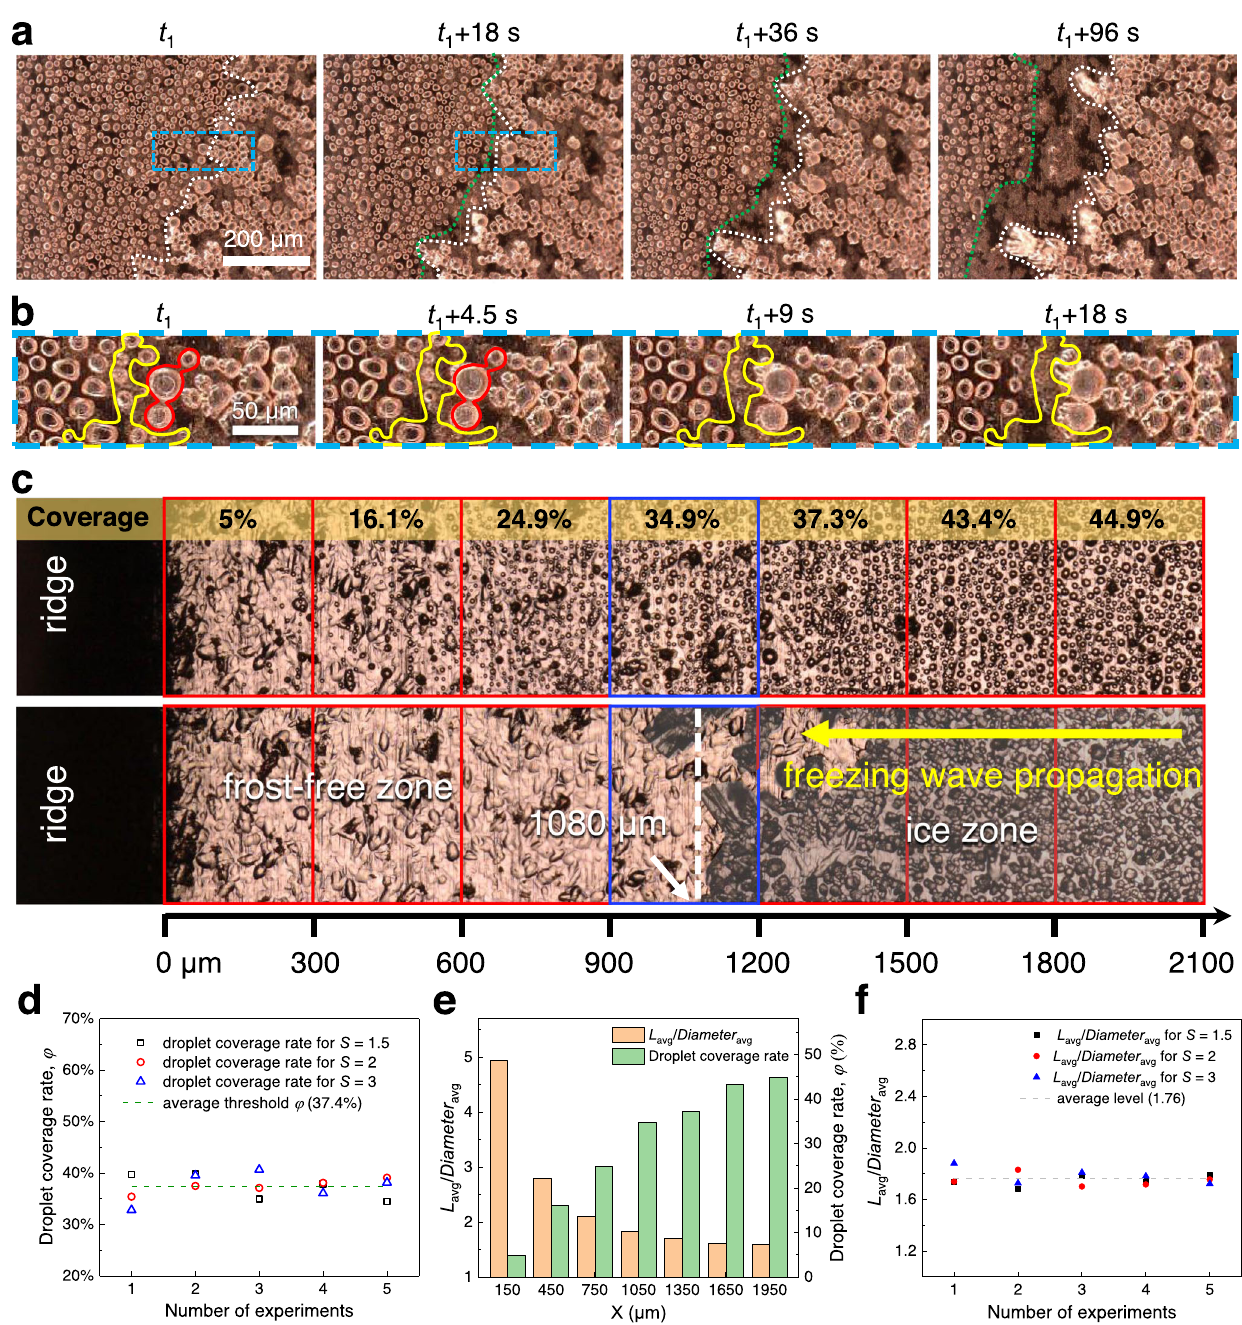
Fig. 3 Failure of ice bridge connection on the macro-ridged surface. a Time-lapse images showing the formation of frost-free zone boundary. b Enlarged partial view showing the details for the failure of inter-droplet ice bridging. Droplets circled in red froze while in yellow evaporated completely. c Division of the surface area for the analysis of droplet coverage rate obtained from Supplementary Figs. S9c, d. The fi rst row shows the droplet distribution just before freezing, while the second one with the ice zone covered by gray shadow shows the formed frost-free zone after freezing. The white dotted line indicates the boundary between the frost-free zone and ice zone. d Droplet coverage rate at the region where the freezing wave propagation terminated at different supersaturation levels. e Bar graph for L avg / Diameter avg and the droplet coverage rate of each region in c , and the position of each column corresponds to the center coordinates of each region. f L avg / Diameter avg for the regions in d where numerous failures of ice bridging